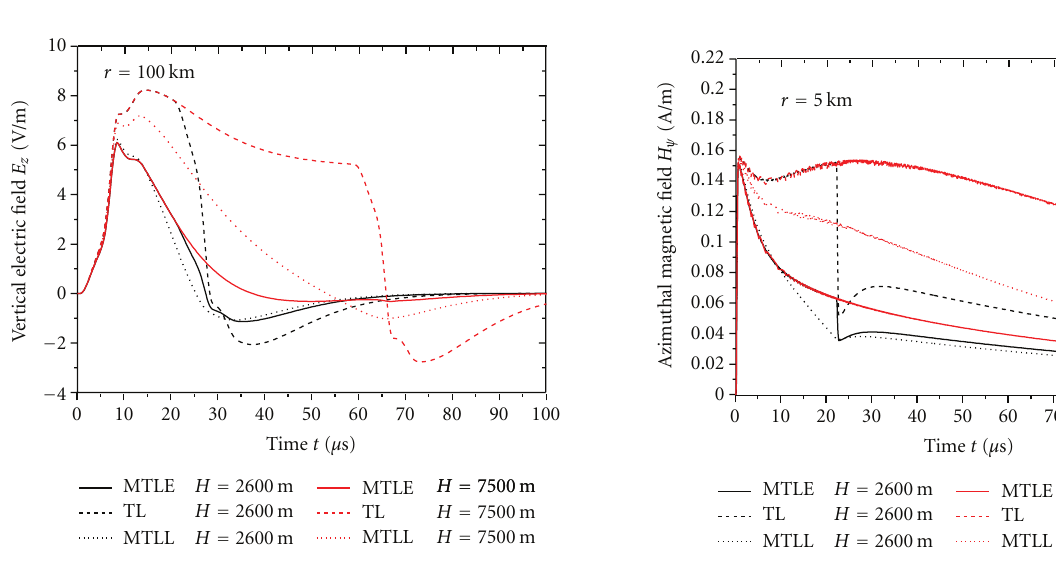
Figure 10: Azimuthal magnetic field at 50m from the channel base for NCBC, three di ff erent models and two channel heights ( H = 2600 m and 7500 m).